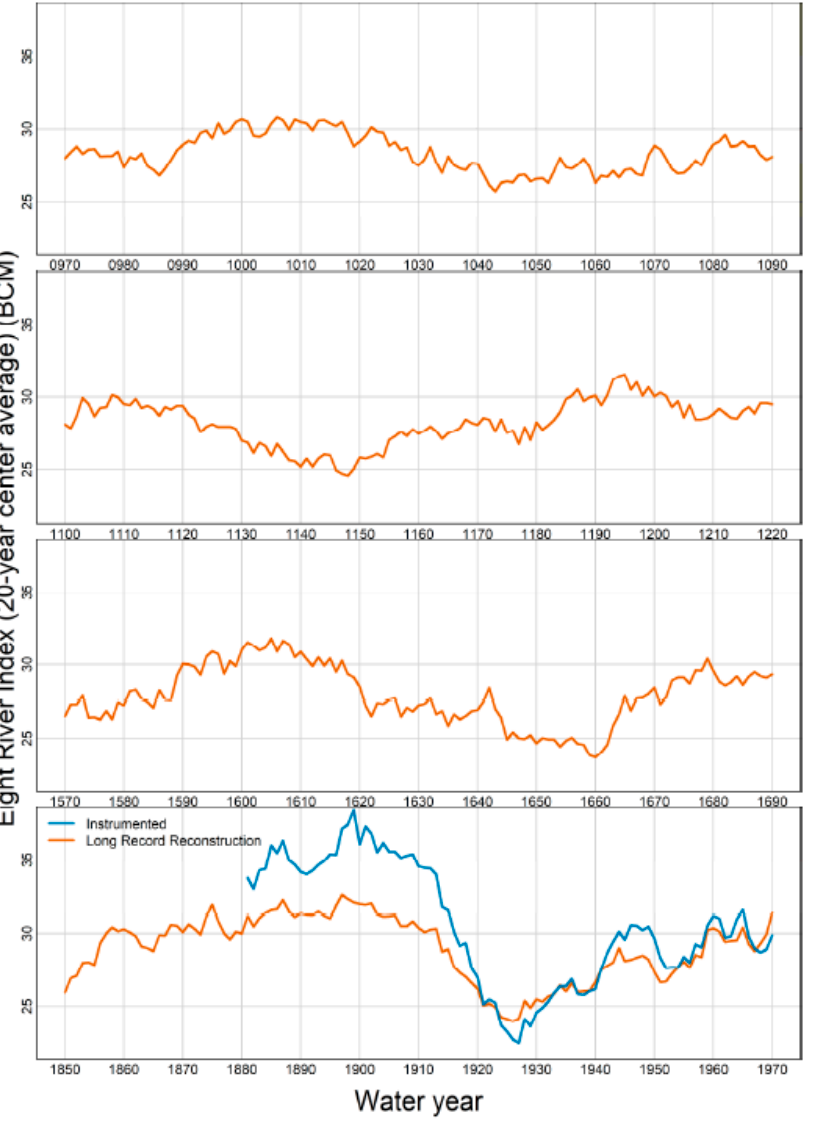
Figure 5. Selected flow periods over the long reconstruction compared with instrumented flow from (20-year centered average for both flow terms).